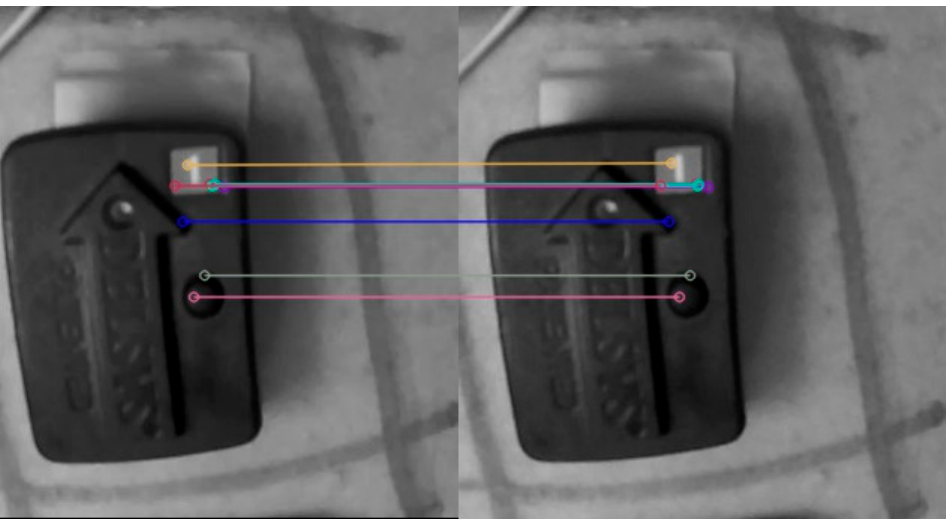
Figure 4. Illustrations of the same feature point in two adjacent frames and the corresponding displacement of the feature points between two adjacent frames.